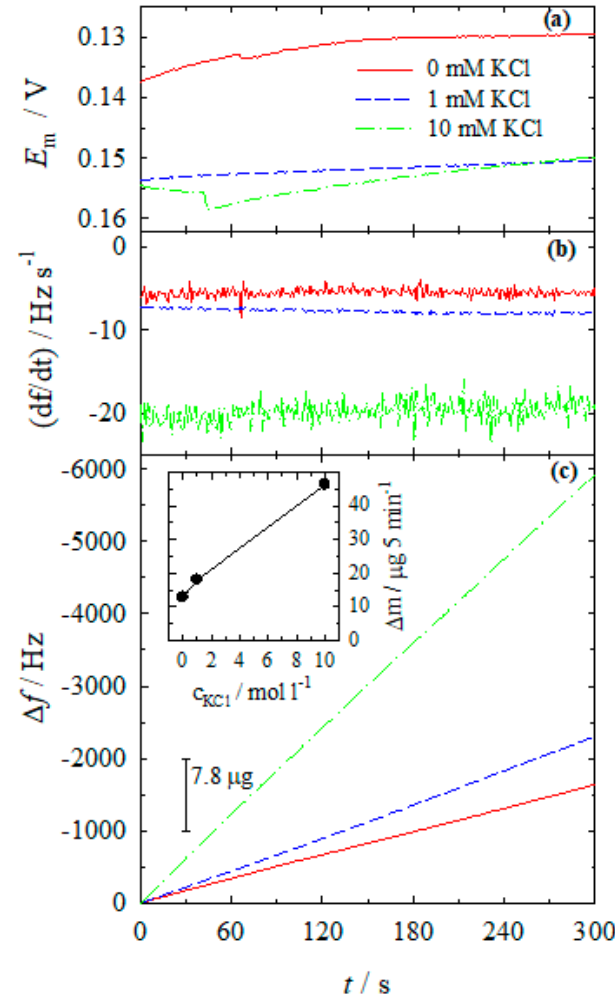
Figure 7. Data on electroless silver deposition on Ag electrode (0.636 cm 2 ): ( a ) open-circuit potential, ( b ) frequency change rate, and ( c ) change in quartz oscillator frequency. Solution composition (M): CoSO 4 —0.1; Ag 2 SO 4 —5 × 10 − 3 ; KCl: 0 (solid line), 10 − 3 (dashed line), 10 − 2 (dash-dotted line); NH 3 —4.0; pH 10.9; 20 °C. The inset represents the mass gain of silver.